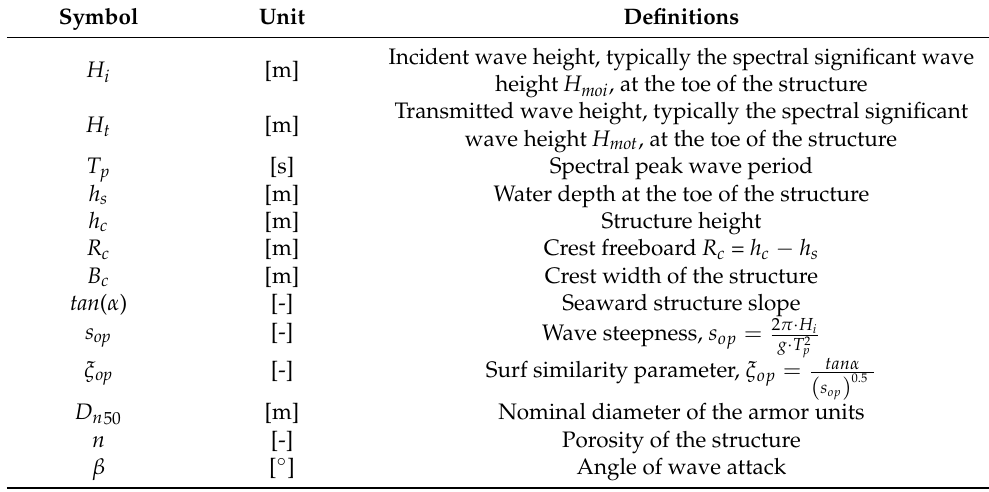
Table 1. Principal influencing wave characteristics and structural parameters involved in the wave transmission